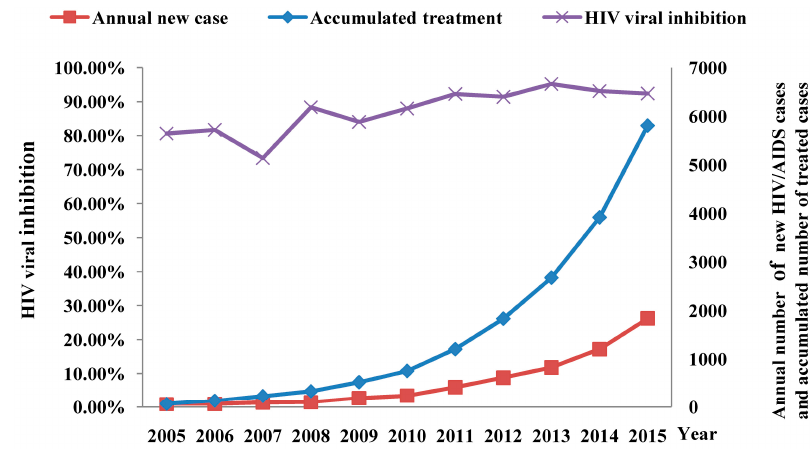
Figure 12. Effectiveness of free antiretroviral treatment program in Fujian Province from 2005 to 2015.